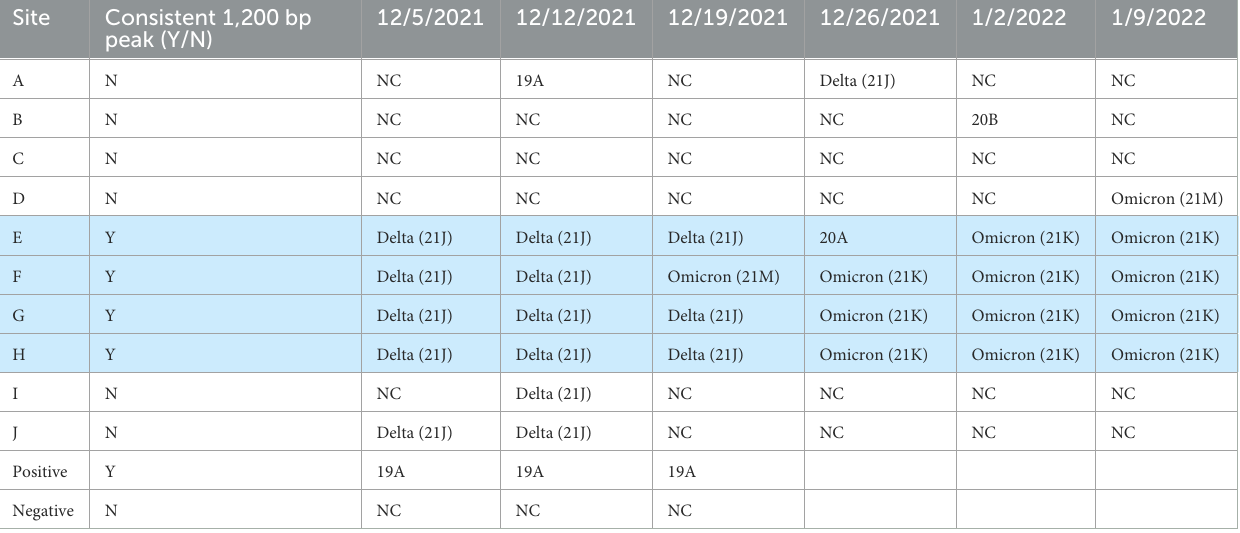
TABLE 4 MinION SARS-CoV variant calls by date and